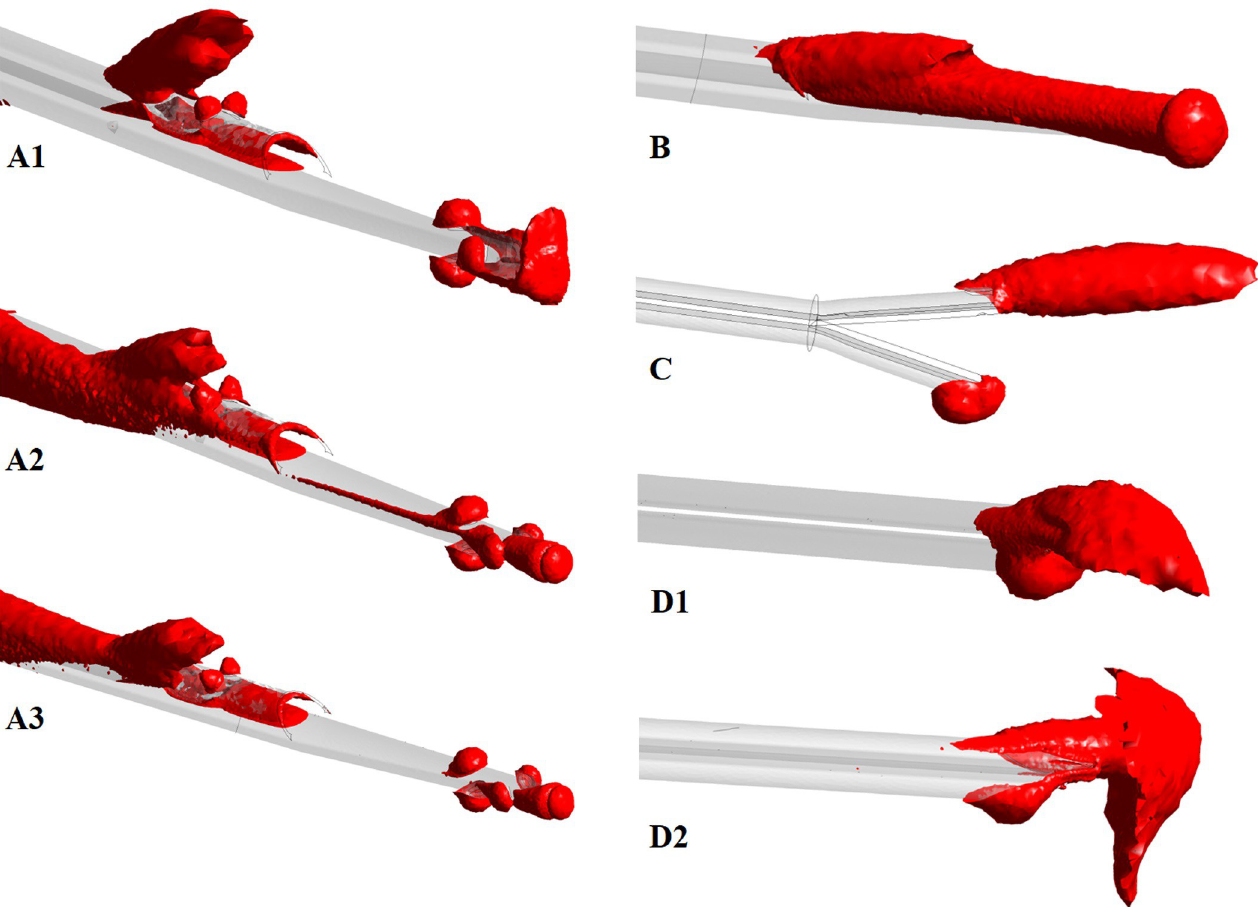
Fig 17. Isosurface regions where blood shear stress is 10 Pa for all models at the beginning of systole t = 0.25 s.